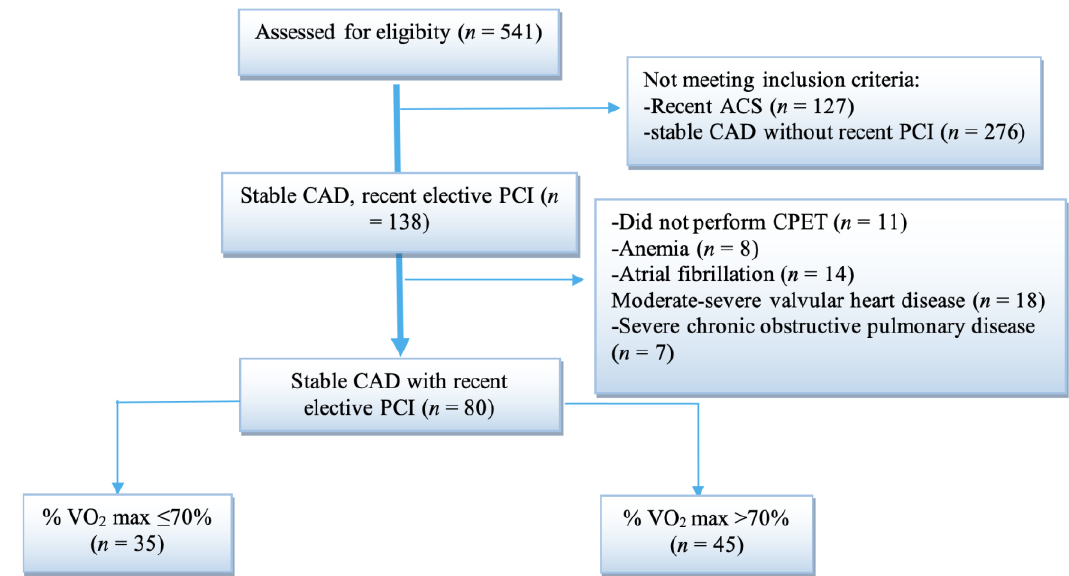
Figure 1. Flow chart diagram of patients hospitalized in the Cardiovascular Rehabilitation Clinic Unit between January 2020 and June 2021. CAD—coronary artery disease, PCI—percutaneous coronary intervention, ACS—acute coronary syndrome, CPET—cardiopulmonary exercise test, % VO2 max—percentage of the predicted value of maximal oxygen uptake.